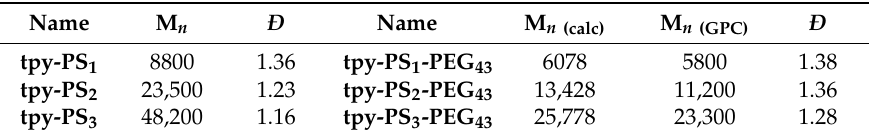
Table 1. Molecular weight (M n ) and dispersity ( Ð ) of the telechelic tpy-PS 1-3 and amphiphiles tpy-PS 1-3 -PEG 43 , as characterized by gel permeation chromatography (GPC).